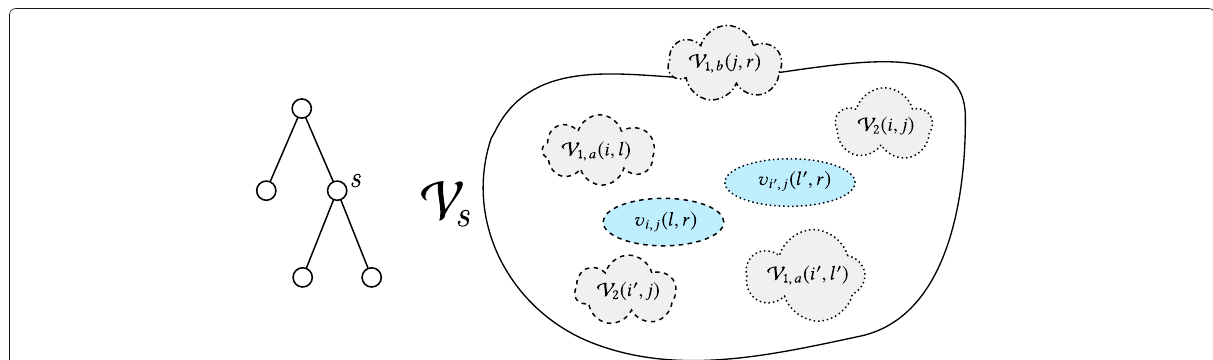
Fig. 5 Illustration of a tree node s and its vertex set V s , which is used to visualize R s ( v ) for the two vertices v i , j ( l , r ) and v i (cid:6) , j ( l (cid:6) , r ) . The corresponding vertex sets for v i , j ( l , r ) are V 1, a ( i , l ) , V 1, b ( j , r ) , and V 2 ( i , j ) and are indicated by dashed contours. The sets V 1, a ( i (cid:6) , l (cid:6) ) , V 1, b ( j , r ) , and V 2 ( i (cid:6) , j ) for v i (cid:6) , j ( l (cid:6) , r ) are shown with dotted contours. The set V 1, b ( j , r ) , which is considered for both vertices, therefore has a dash-dotted contour. The purpose of visualizing R s ( v ) for the two vertices is to check whether all vertices of the abovementioned sets V • ( • , • ) are already included in the vertex set V s at the current tree node s . For the two vertices in the example above, we have R s ( v i , j ( l , r )) = vertices, the corresponding set V 1, b ( • , • ) is not fully included in V s . Consequently, both vertices share the same property, which is captured by R s ( v i , j ( l , r )) = R s ( v i (cid:6) , j ( l (cid:6) , r )) . Therefore, they also have the same label